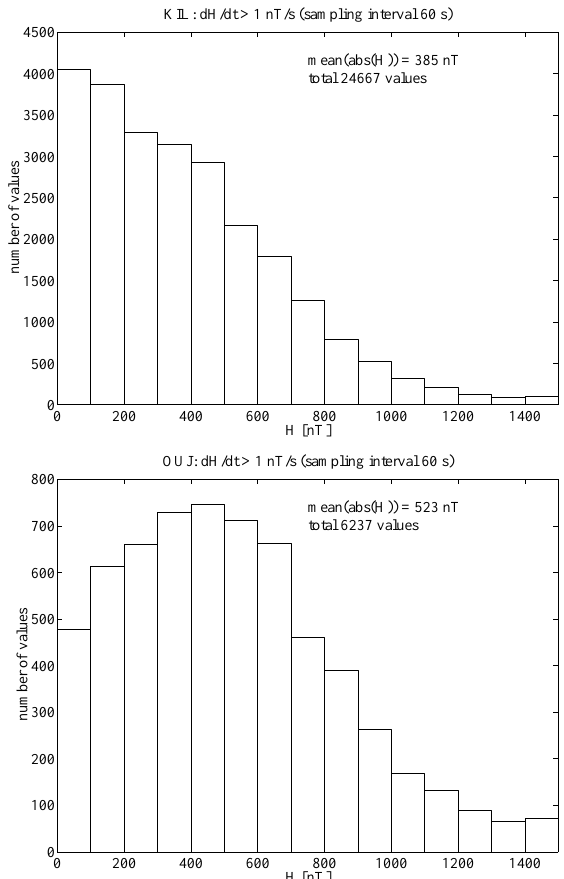
Fig. 5. Distribution of the amplitudes of the ∆ H vectors used in Fig. 4. When all available values from 1994 to 2000 are used, the averages are 33nT at OUJ and 60nT at KIL.